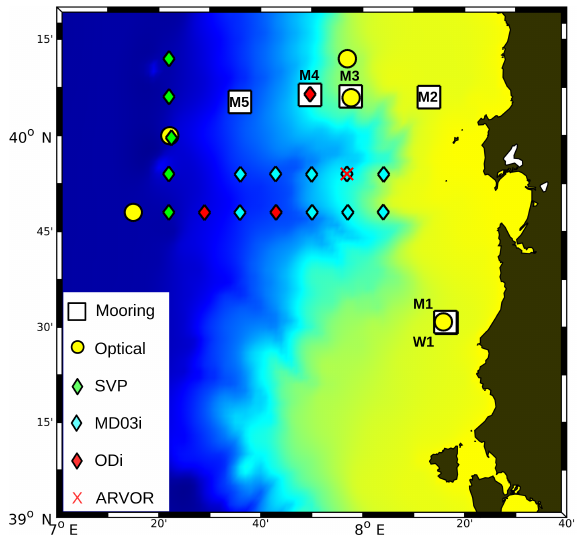
Figure 9. Positions of moorings, optical stations, and deployment positions of surface drifters (SVP, MD03i, and ODi are drifter types) and the ARVOR-I float. The colour code for the water depth is the same as in Fig. 2.